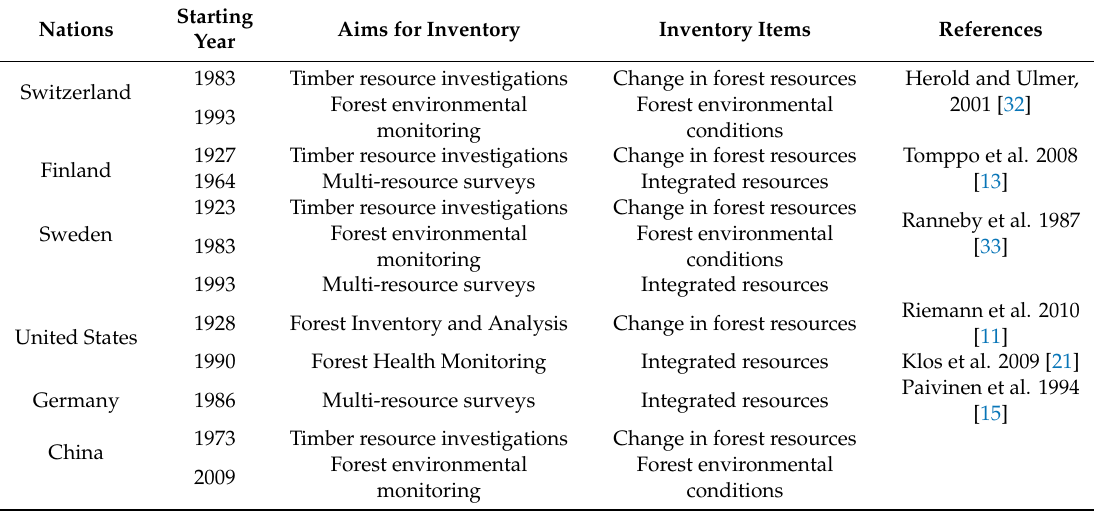
Table 1. International forest ecosystem inventories compared with